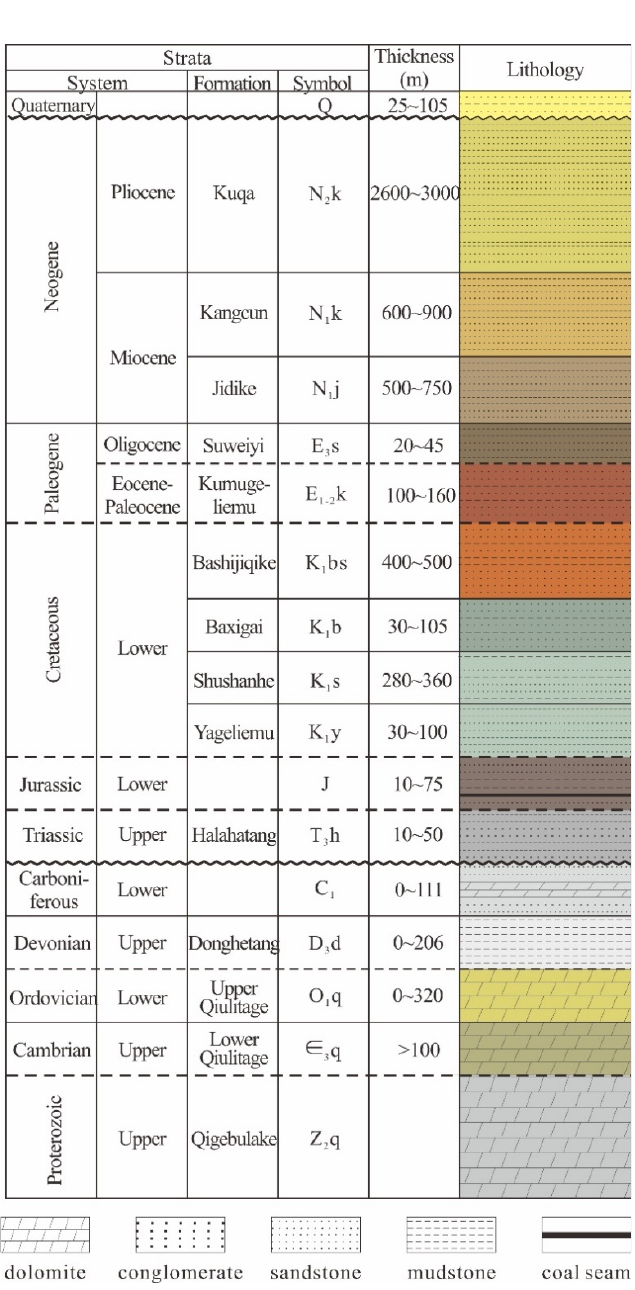
Figure 2. Stratigraphy column of study area.